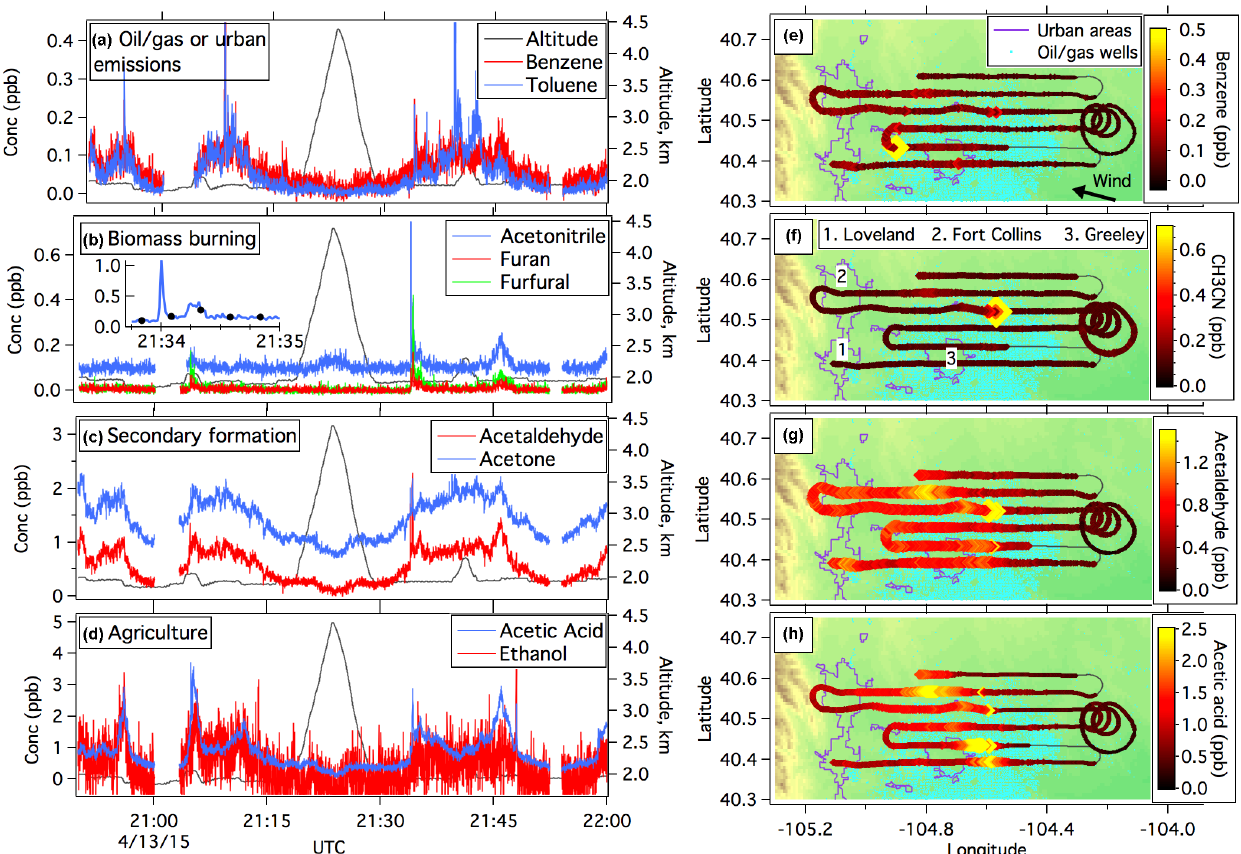
Figure 12. VOC measurements by the H 3 O + ToF-CIMS for the characterization of air masses and atmospheric photochemistry during a part of the flight (20:50–22:00UTC) on 13 April 2015 over the Denver–Julesburg basin. Time series of various VOC species from oil/gas or urban emissions (a) , biomass burning (b) , secondary formation (c) and agricultural emissions (d) are shown. The inserted plot in (b) highlights acetonitrile around 21:34UTC, where the black dots indicate re-sampled acetonitrile data every 15s, reflecting measurement results had a PTR–QMS been deployed on board the NOAA WP-3D. Flight tracks color-coded using mixing ratios of benzene (e) , acetonitrile (f) , acetaldehyde (g) and acetic acid (h) are shown in the right panels. Urban regions and locations of oil and gas wells are indicated in the right panels. The arrow in (e) indicates wind direction in the boundary layer during this